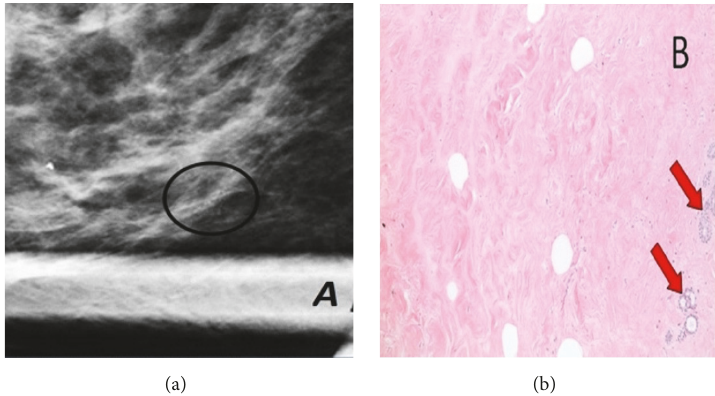
Figure 1: 57-year-old woman presenting for screening mammography. (a) Spot magnification view of the right breast in mediolateral position showssegmentalamorphouscalcifications.Afollow-upmammogramwasobtained7monthsfollowingthebiopsyshowingstableappearance.